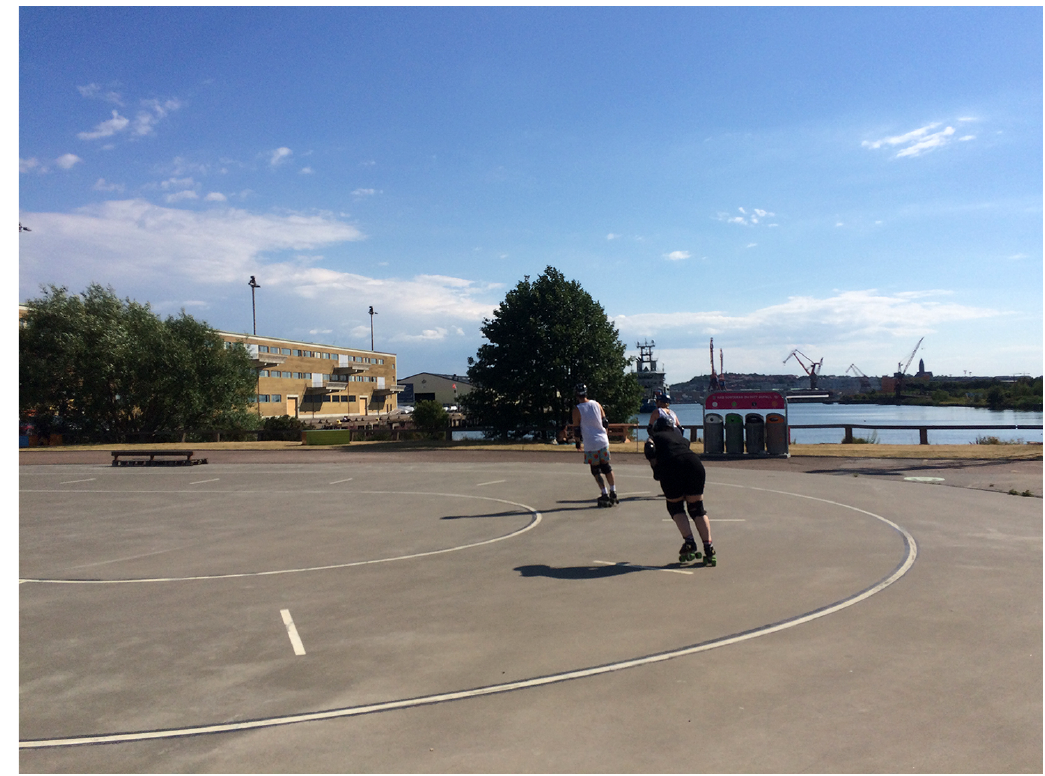
Figure 3. Roller derby training at Jubileumsparken (2018). Photo: Ida